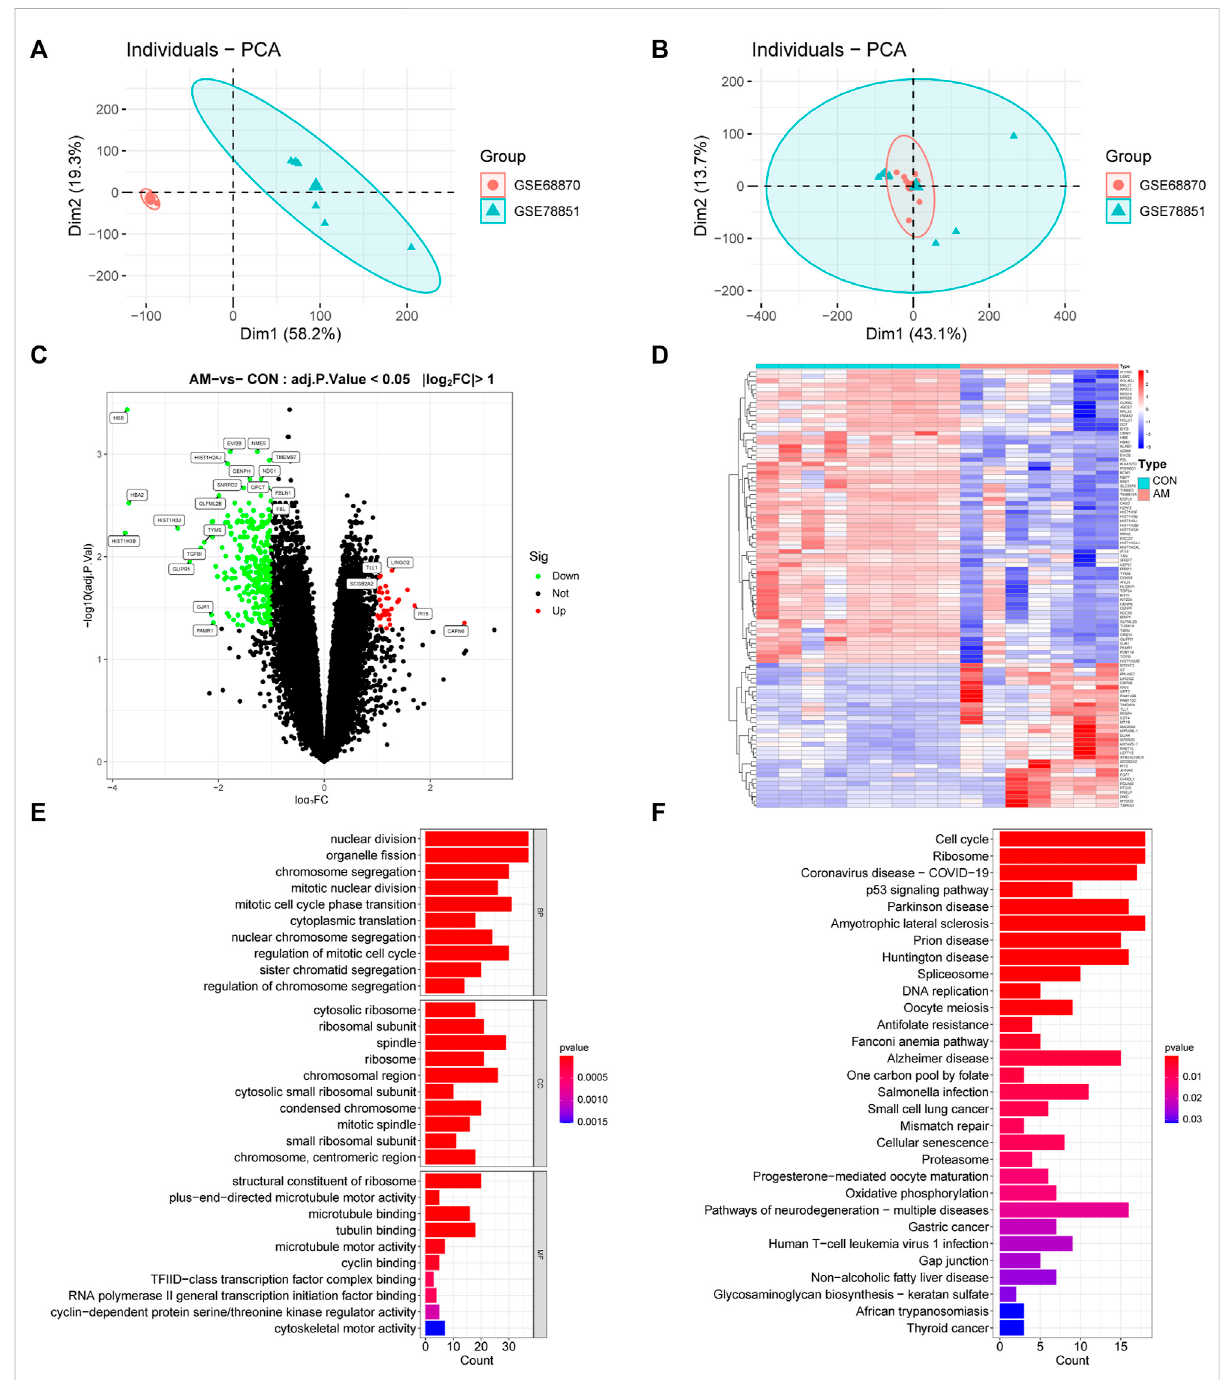
FIGURE 2 AnalysisofDEGspro fi leinendometriumbetweenwomenwithadenomyosisandcontrols. (A) ThePCAplotofsampledistributionfromthetwo datasets before removing thebatch effects. (B) The PCA plotofsample distribution from thetwo datasets after removing thebatch effects. Different colorsrepresentdifferentdatasets. (C) VolcanoplotofDEGs.Thereddotsrepresenttheup-regulatedgenesandthegreendotsrepresentthedown- regulated genes in the adenomyosis group. (|log2 FC | ≥ 1; adjusted p -value < 0.05). (D) Heatmap of DEGs; red indicates upregulated genes and blue indicates downregulated genes in the adenomyosis group. (E) GO enrichment analysis of DEGs. The top 10 BP, MF, and CC terms of DEGs. (F) The top 30 KEGG pathway enrichment analysis of DEGs. AM: adenomyosis group; BP: biological process; CC: cellular component; CON: control group; DEGs: differentially expressed genes; FC: fold change; GO: Gene Ontology; KEGG: Kyoto Encyclopedia of Genes and Genomes; MF: molecular function; PCA: principal component